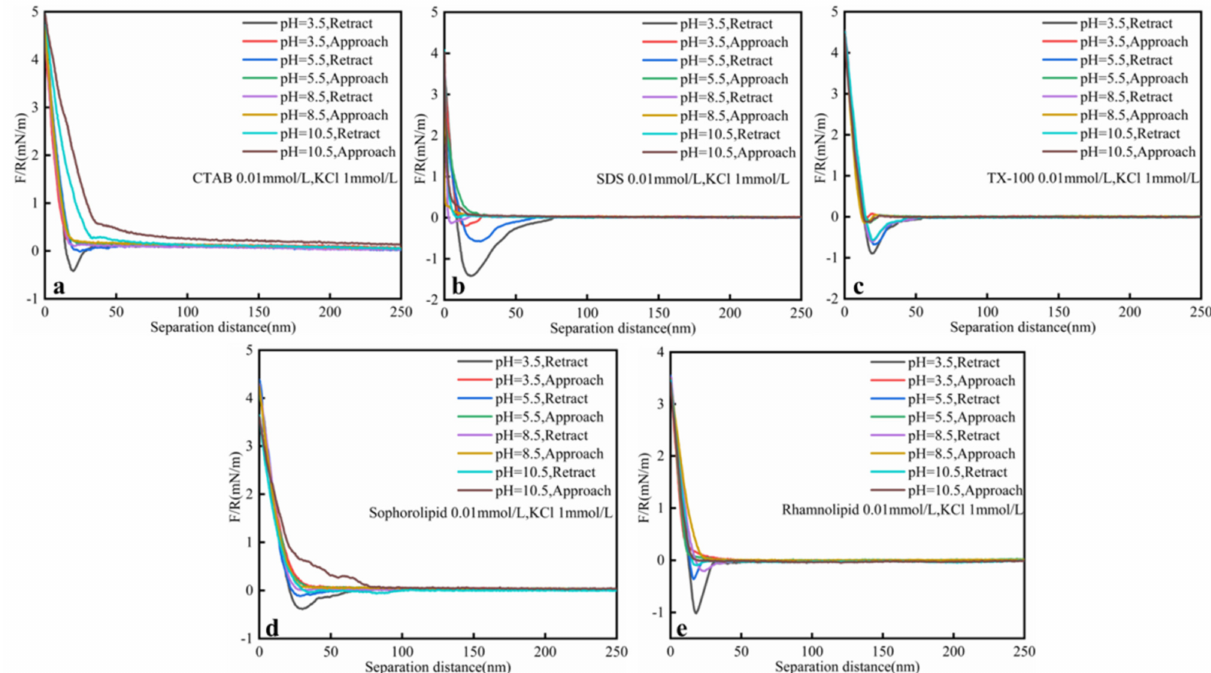
Figure 6. Interaction forces (F/R) between heavy oil and calcium carbonate at different pH surfactants ( a ) CTAB; ( b ) SDS; ( c ) TX-100; ( d ) Sophorolipid; ( e ) Rhamnolipid solutions as a function of the separation distance at ambient conditions (0.01 mmol/L surfactants, 25 ◦ C, 1 mmol/L KCl, 45 ppm asphaltenes). Table 5. Adhesion forces (F/R) between heavy oil and calcium carbonate in different pH at